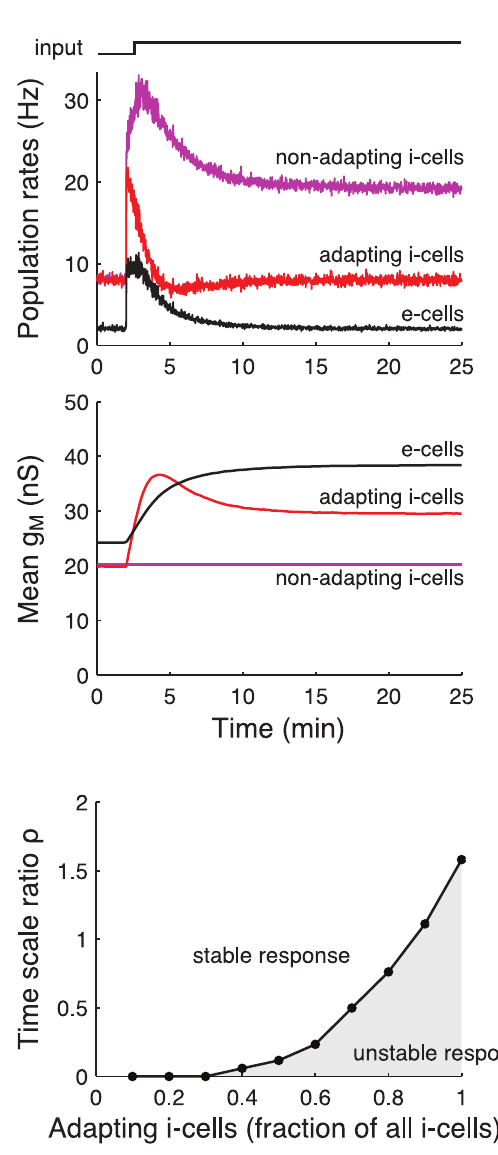
Figure 3. Adapting to a persistent change in external drive to a recurrent network that includes two types of inhibitory cells. A: Response of a recurrent network with two types of i-cells: half of the i- cells show HSE while the other half does not show HSE at the depicted time scale. All cells are perturbed by a 1.2 kHz step increase in the external drive (top trace). Top panel shows the population mean of the instantaneous firing rates of the e-cells (black), the adapting i-cells (red), and the non-adapting i-cells (magenta), computed for 1 second bins. Bottom panel shows the population mean g M of the three populations. The adaptation time scale ratio r of the (adapting) i-cells to the e-cells is 0.5. The compound external drive to all cells before the input increase is 1.2 kHz. B: Ratio of adaptation time scales r that is required for adaptation dynamics to be stable when the fraction of all i-cells that adapt is varied from 10% to 100%. The network is perturbed from its adapted state (to a 1.2 kHz external drive) by a 0.3 kHz step increase of the external drive to all cells. The same criterium for stability of the adaptation dynamics is used as in figure 2. averaged activity levels remain close to the target state ( E ? , I ? ), so that both populations function within their dynamic range. The variables S e ( t ) and S i ( t ) evolve as